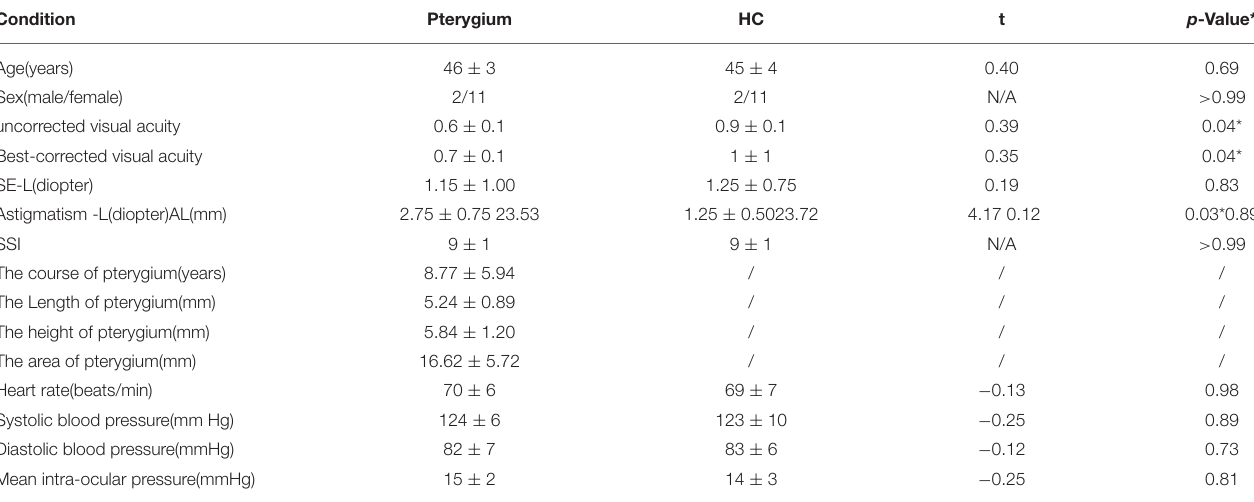
TABLE 1 | Demographic characteristics and clinical findings of patients with Pterygium and HCs.